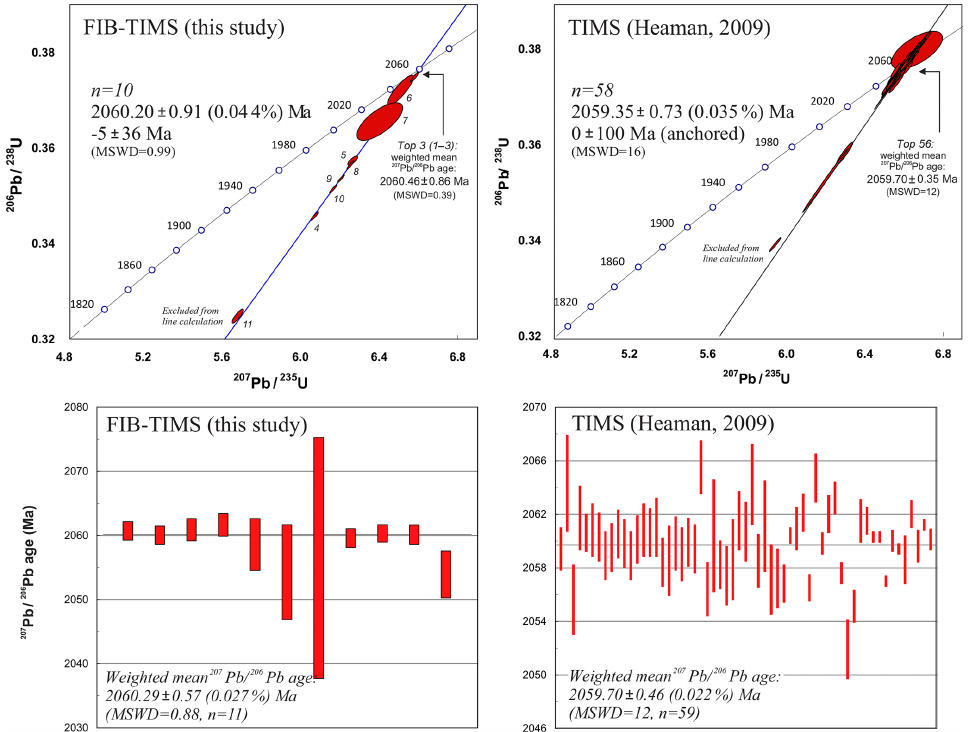
Figure 3. U–Pb concordia diagrams and weighted average Pb / Pb ages for data generated by FIB-TIMS and TIMS analysis of the Phalaborwa baddeleyite reference material within this study (left). For comparison, all U / Pb and Pb / Pb data reported by Heaman (2009) are also presented (right), highlighting the natural discordance and variation within the Phalaborwa baddeleyite population. Individual data points are numbered in reference to Table